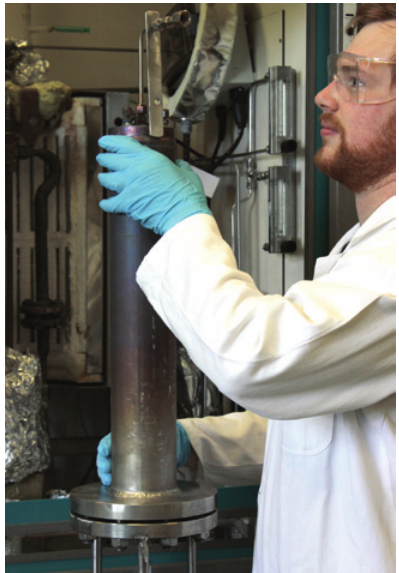
Figure 4: Reactor for the synthesis of higher alcohols. © Fraunhofer UMSICHT.